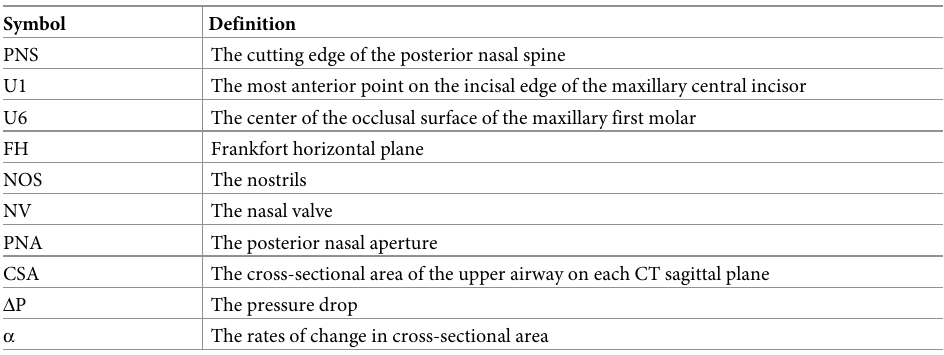
Table 1. Definitions of landmarks.